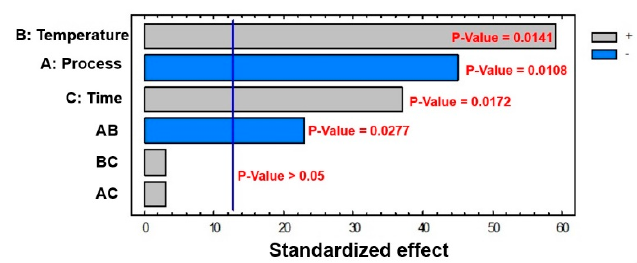
Figure 8. Pareto chart for conversion related to the WCK and WCS processes.